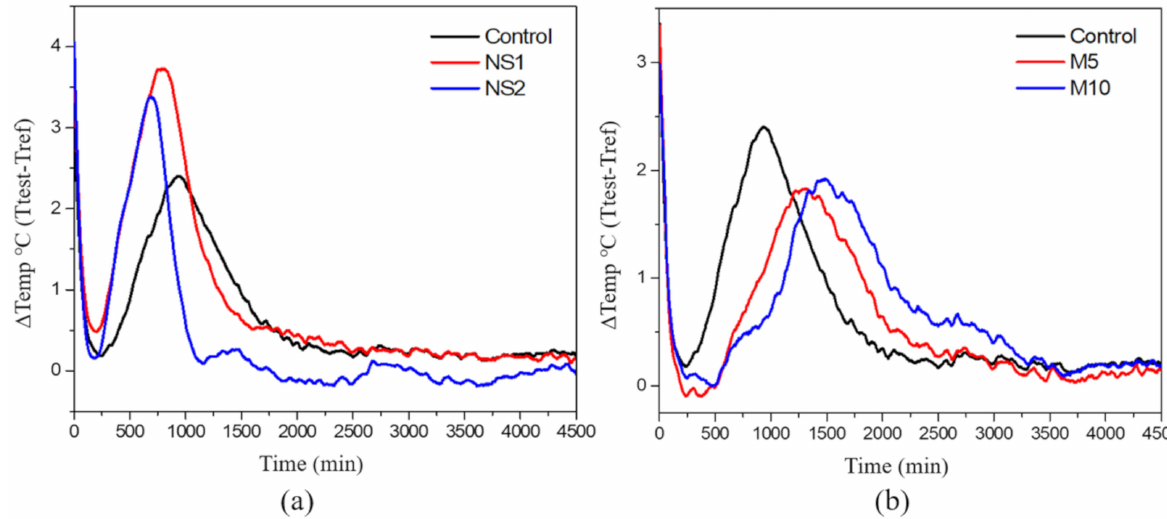
Figure 7. Calorimetric curves of the rate of heat release of ( a ) UWC with different NS contents and ( b ) UWC with different amounts of